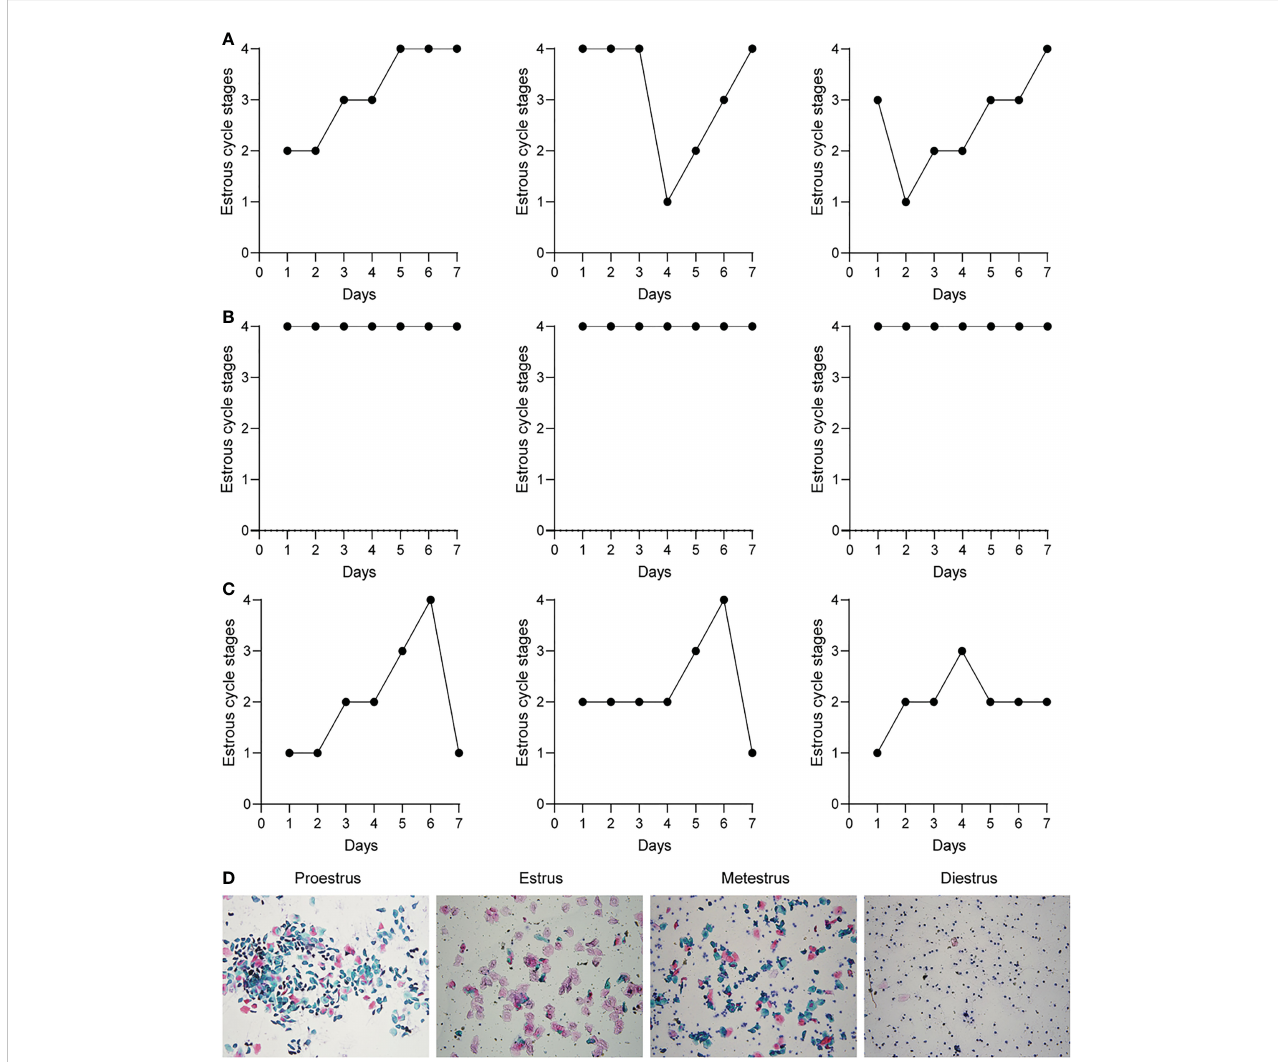
FIGURE 2 Metformin improves ovarian function in PCOS mice. (A) The estrous cycle of three representative mice in the normal group after treatment for 7 consecutive days; (B) The estrous cycle of three representative mice in the PCOS group after treatment for 7 consecutive days; (C) The three representative mice in the Met group after treatment The estrous cycle of 7 consecutive days; (D) Pap staining of mouse estrous cycle smears. The ordinate is as follows: 1. Pre-estrus; 2. Estrus; 3. Estrus and 4.